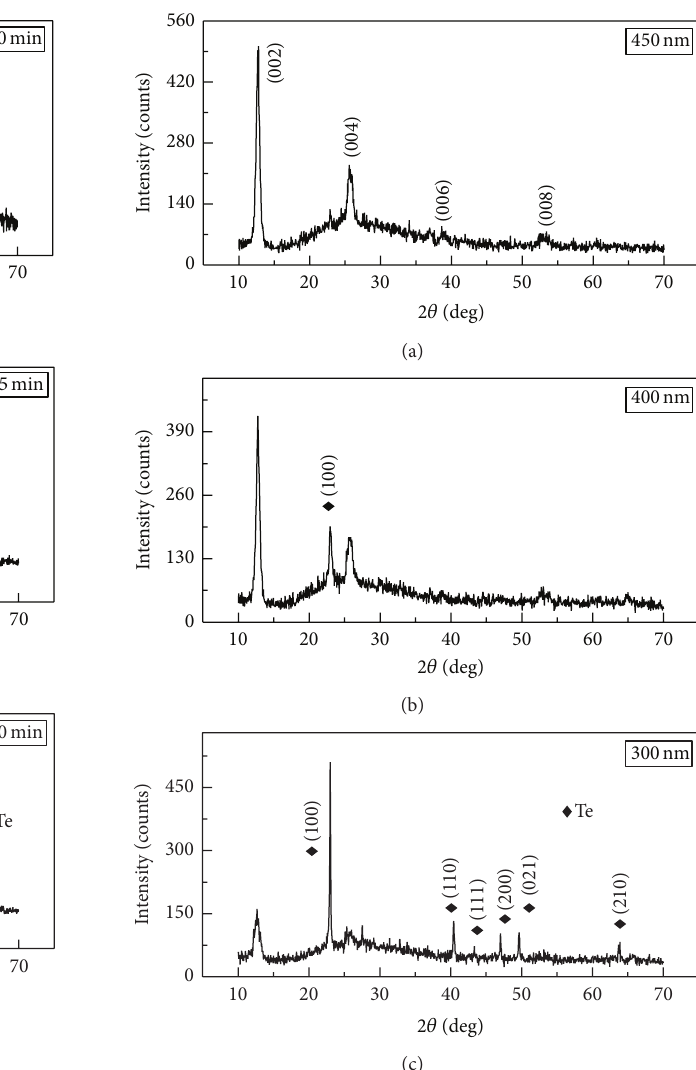
Figure 6: XRD patterns of Mo-Te thin films with thickness of 450 nm annealed at 470 ∘ C for different times in N 2 ambient. Figure 7: XRD patterns of Mo-Te thin films annealed at 470 ∘ C in N 2 ambient with different